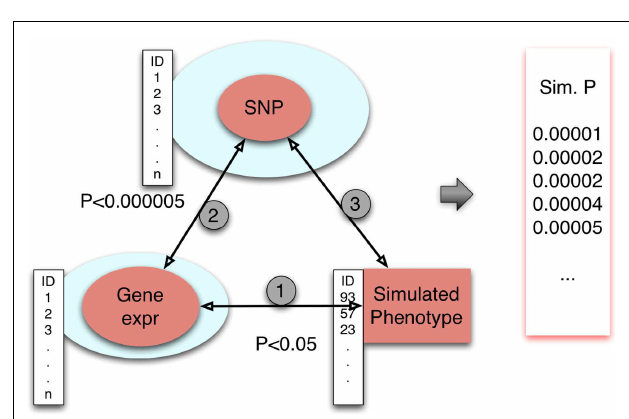
FIGURE 4 | Simulating the null distribution. Simulated phenotypes were obtained by permuting phenotype values. Associations between gene expression traits and phenotype were done conditional on preserved correlation structure between the gene expression traits.The eQTLs for selected genes were retrieved from our eQTL database SCAN. Finally, the eQTLs were tested for association with phenotype. For each of n = 1000 replicates, a set of SNP association p -values is